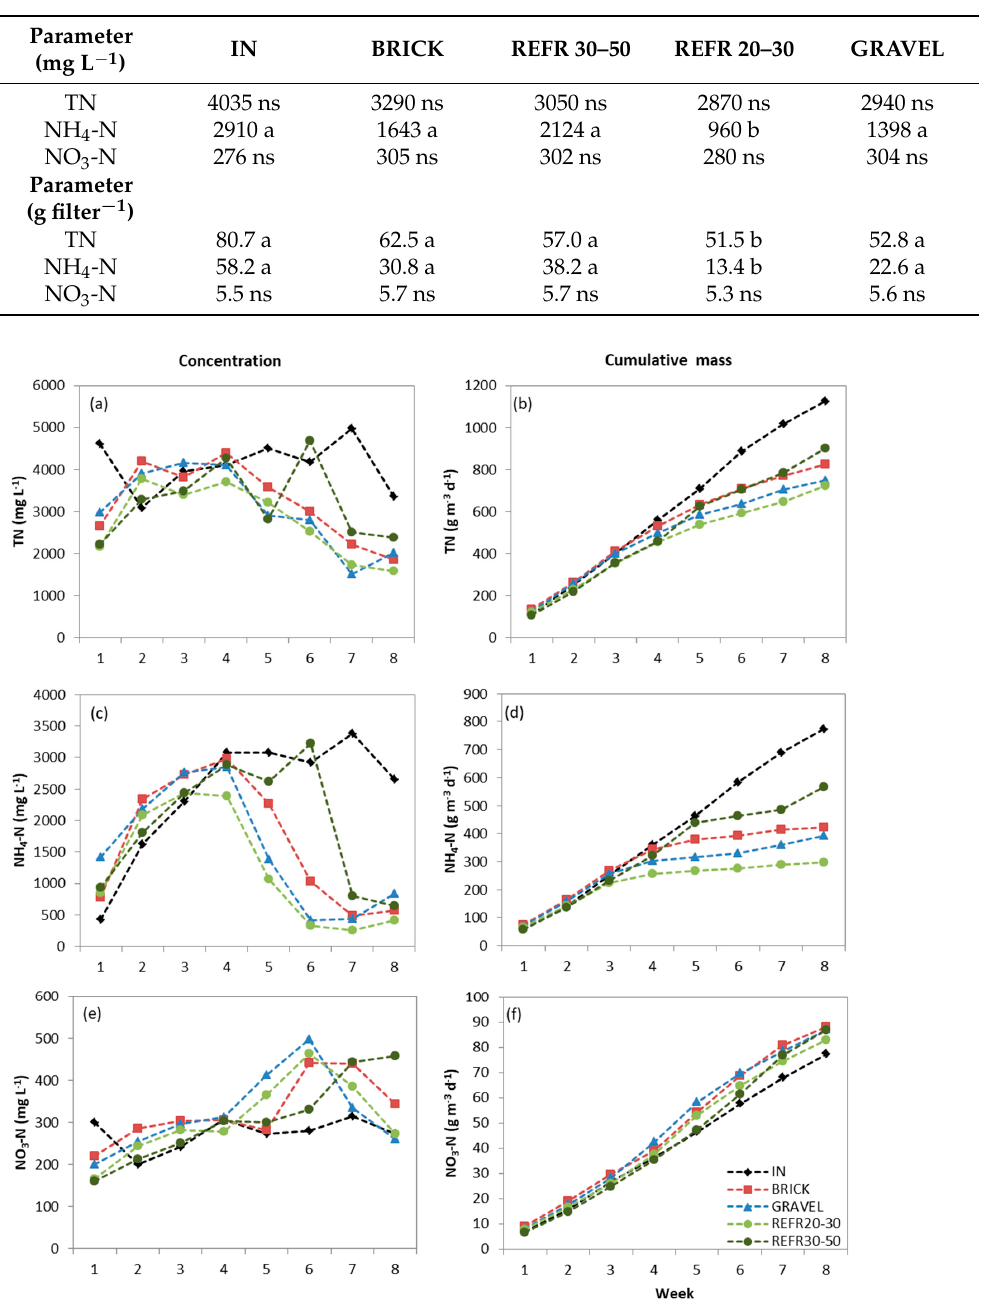
Figure 2. Total nitrogen (TN), ammonia–nitrogen (NH 4 -N), and nitrate–nitrogen (NO 3 -N) during the eight-week experiment. Values are expressed as concentration ( a , c , e ) and cumulative mass balance ( b , d , f ).